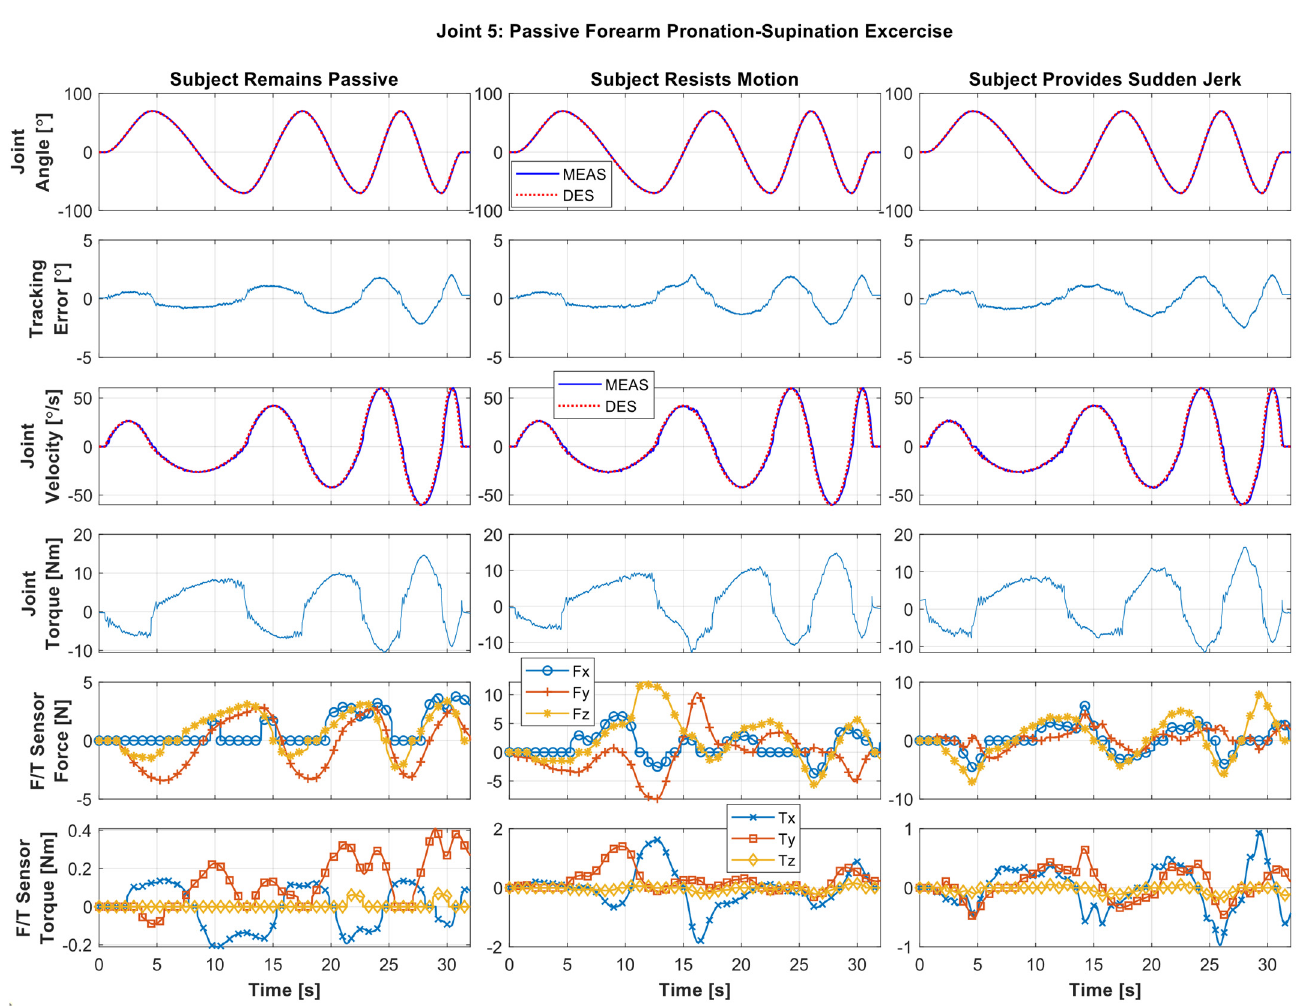
Figure 7. Passive forearm pronation (70 ◦ )/supination (70 ◦ ) exercise where Subject C exerts no force during the exercise ( left column), resists the motion ( middle column), and provides sudden jerk motion throughout the exercise ( right